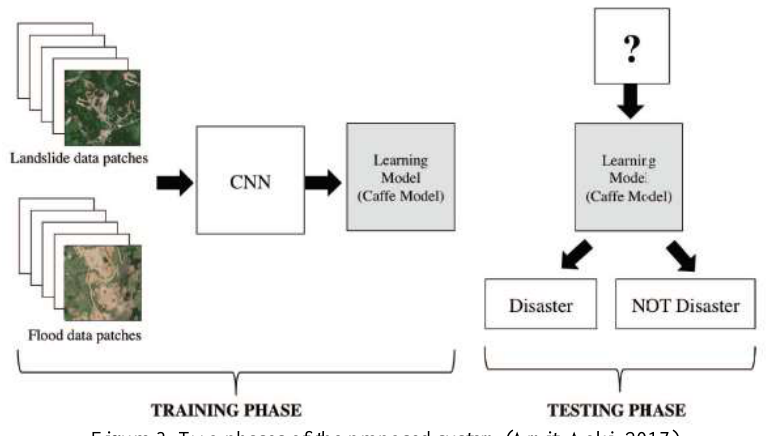
Figure 3. Two phases of the proposed system (Amit, Aoki, 2017)